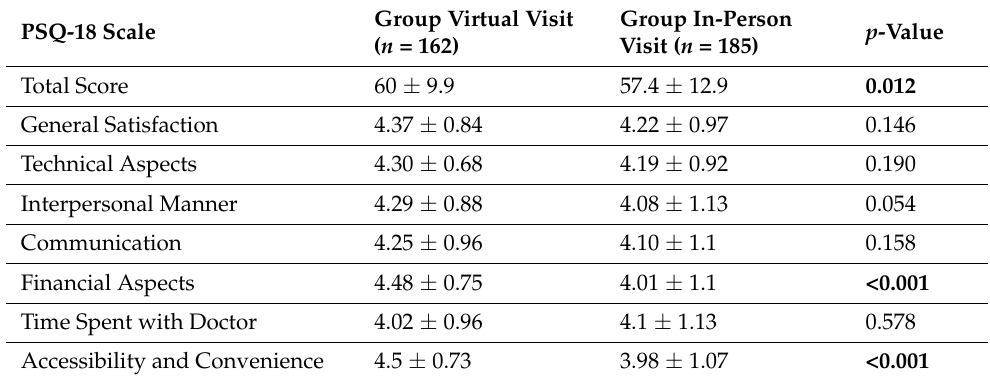
Table 3. Results from the PSQ-18.